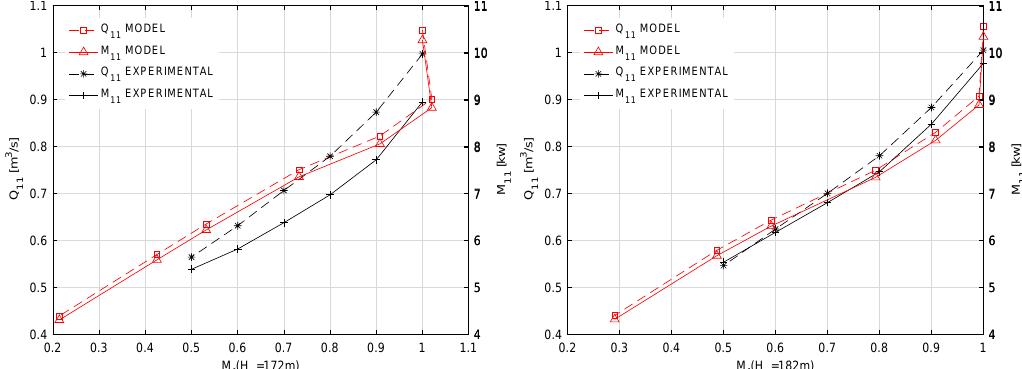
Figure 10. Comparisons of numerical and experimental data, at different heads and power factors, in turbine conditions.